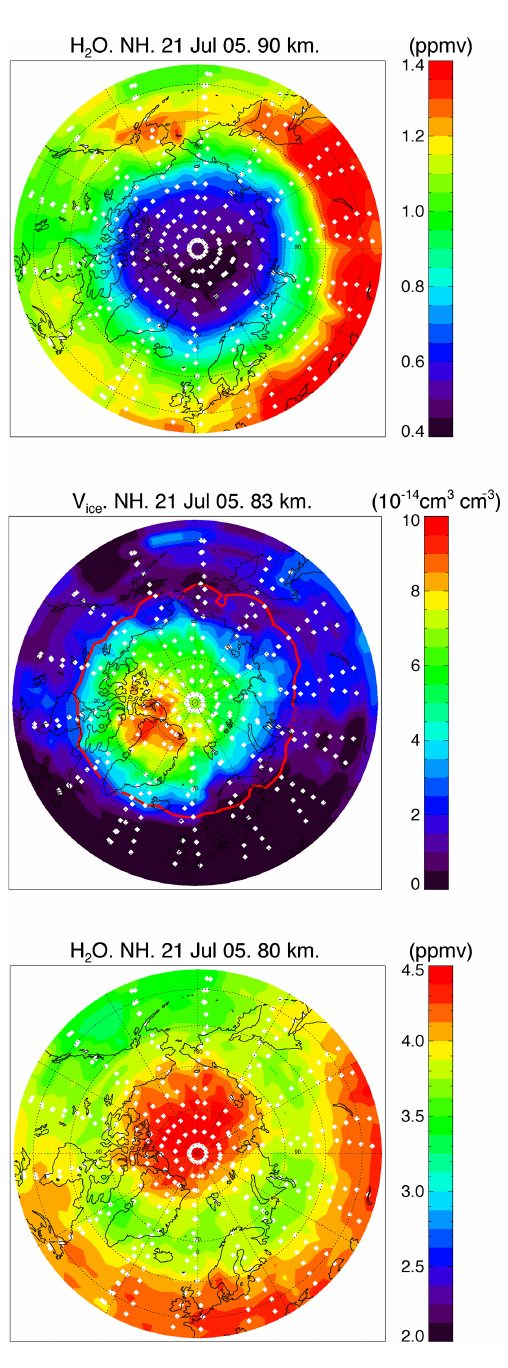
Figure 11. Polar maps of H 2 O vmr for altitudes of 90km (top) and 80km (bottom) (note the different scales) and of ice volume density at 83km (middle panel) for 21 July 2005 (see Fig. 10). The white diamonds represent the geolocations of MIPAS